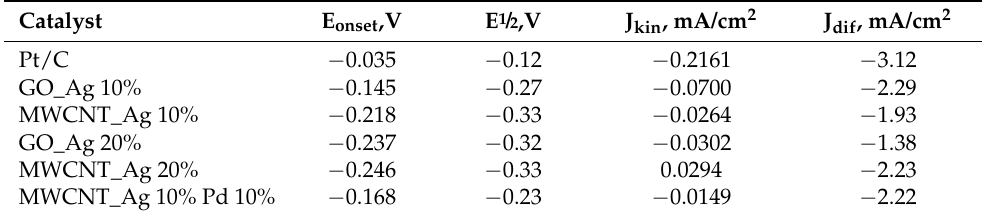
Table 3. Parameters of the reaction of electroreduction of oxygen on synthesized catalysts.